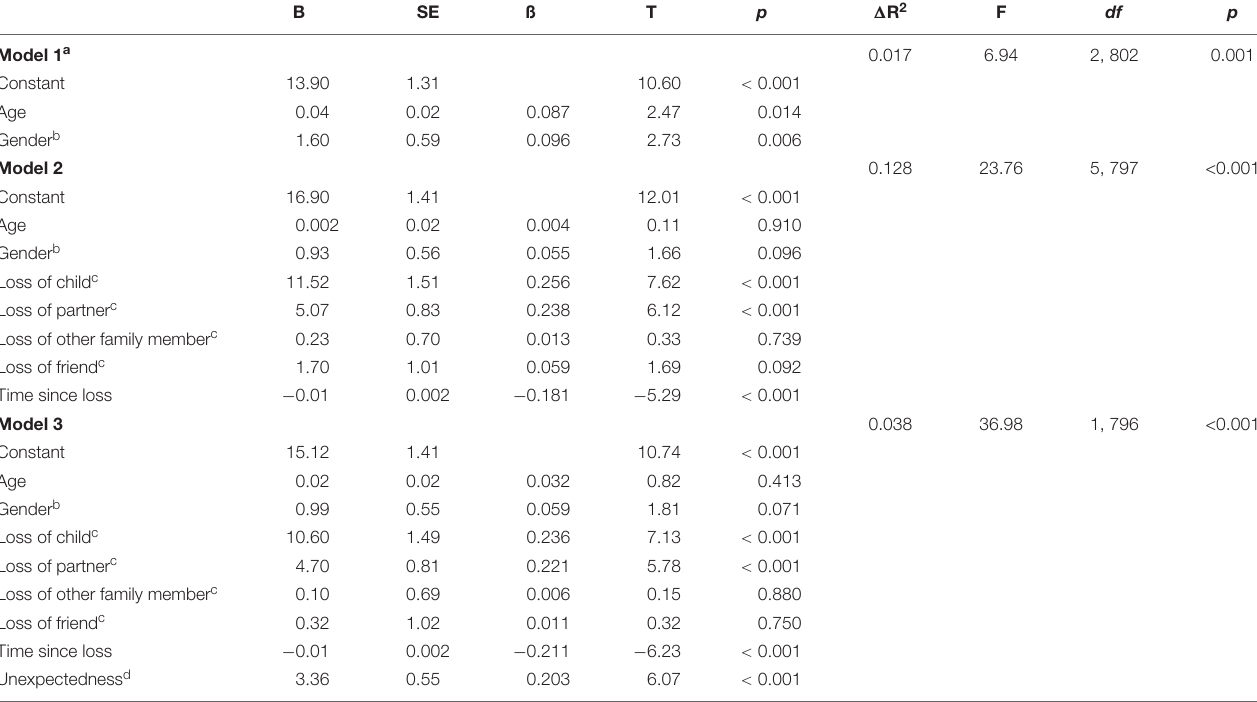
TABLE 3 | Blockwise hierarchical linear regression with the criterion grief severity.